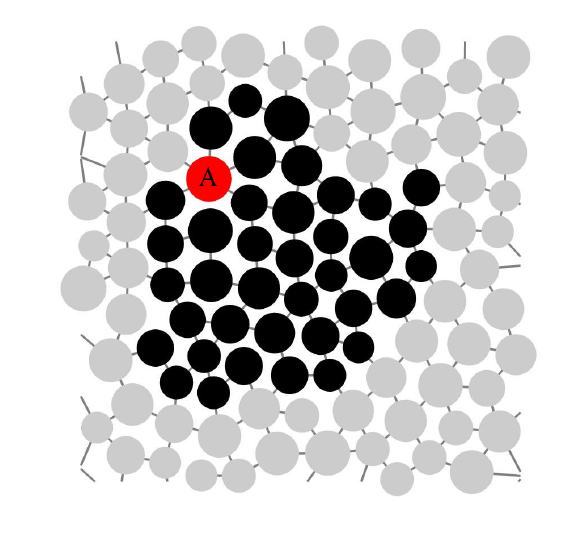
Figure 1. Fragile cluster of Particle A .